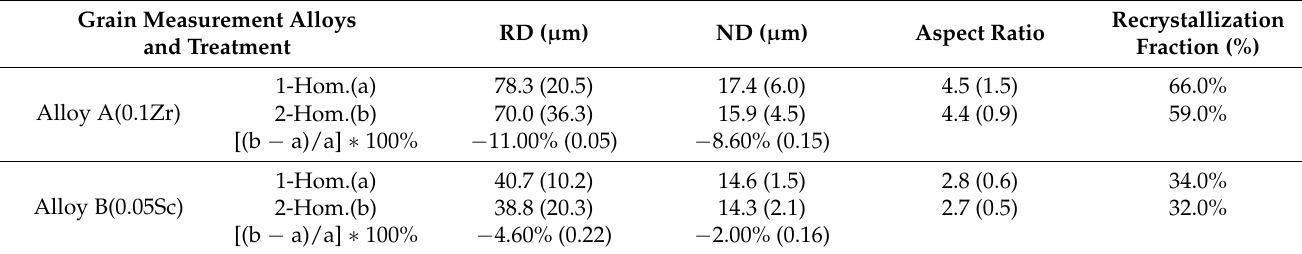
Figure 5. Microstructures observation by OM after T6 temper (1 h solution treatment and aging): ( a ) 1-Hom. alloy A(0.1Zr); ( b ) 1-Hom. alloy B(0.05Sc); ( c ) 2-Hom. alloy A(0.1Zr); ( d ) 2-Hom. alloy B(0.05Sc); ( e ) cross-sectional direction. ND, normal direction; RD, rolling direction. Table 2. Grain size, aspect ratio and recrystallization fraction by different homogenization after T6 heat treatment of alloy A and alloy B.